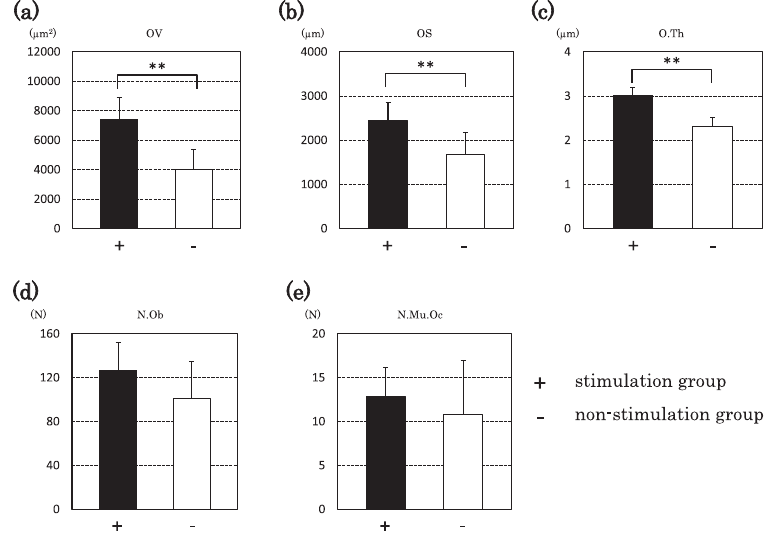
Figure 4 Bone histomorphometry (primary parameters) Parameters of bone structure are shown. The graphs show results for osteoid volume (OV), osteoid surface (OS), osteoid thickness (O.Th), osteoblast number (N.Ob) and multinuclear osteoclast number (N.Mu.Oc). Black bars represent the stimulation group (+) and white bars represent the non- stimulation group (–). Significant differences were observed (**p<0.01). The number of animals in each group was six.